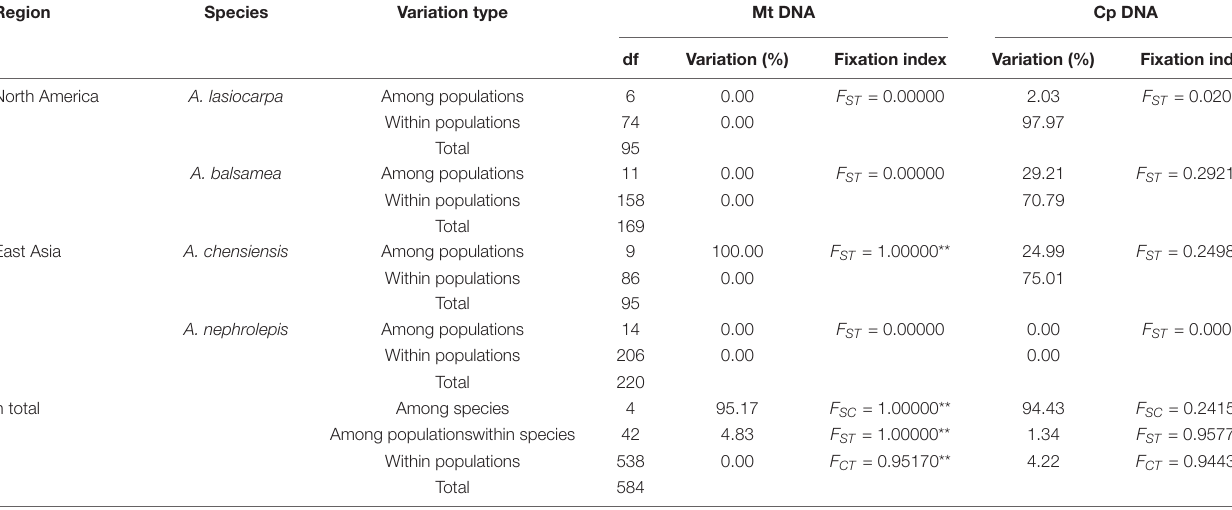
TABLE 1 | The results of molecular variance analyses. Region